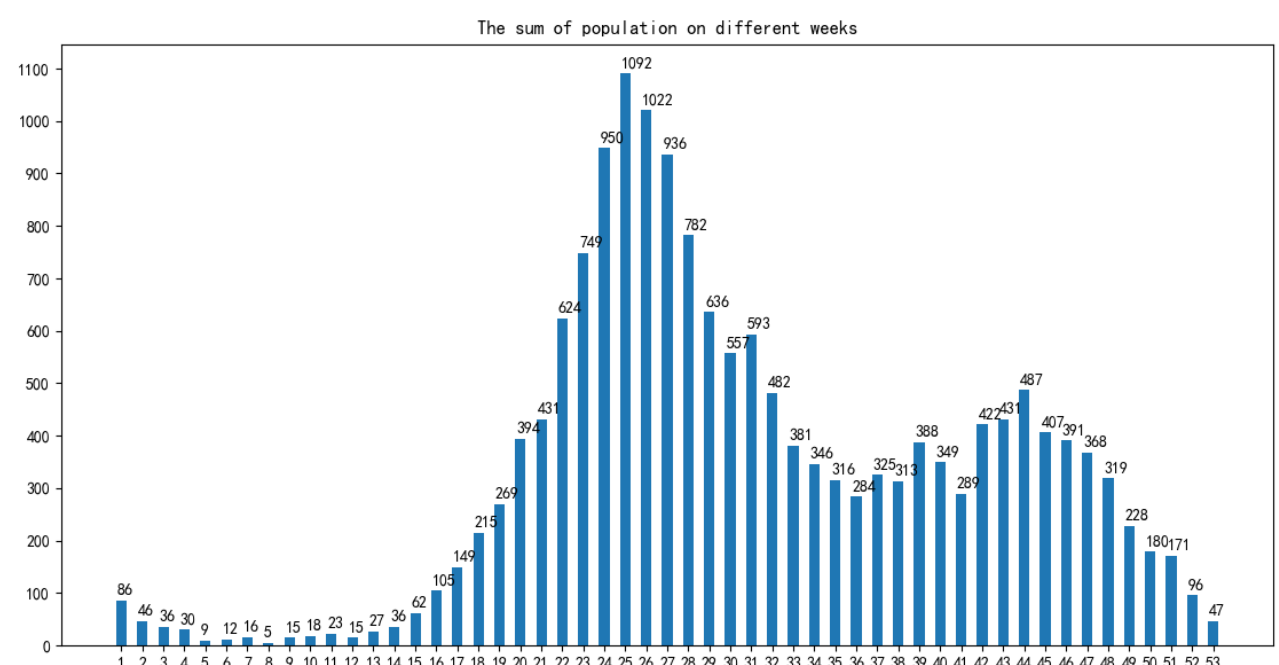
Figure 4. HFMD’s proportion of each population category.